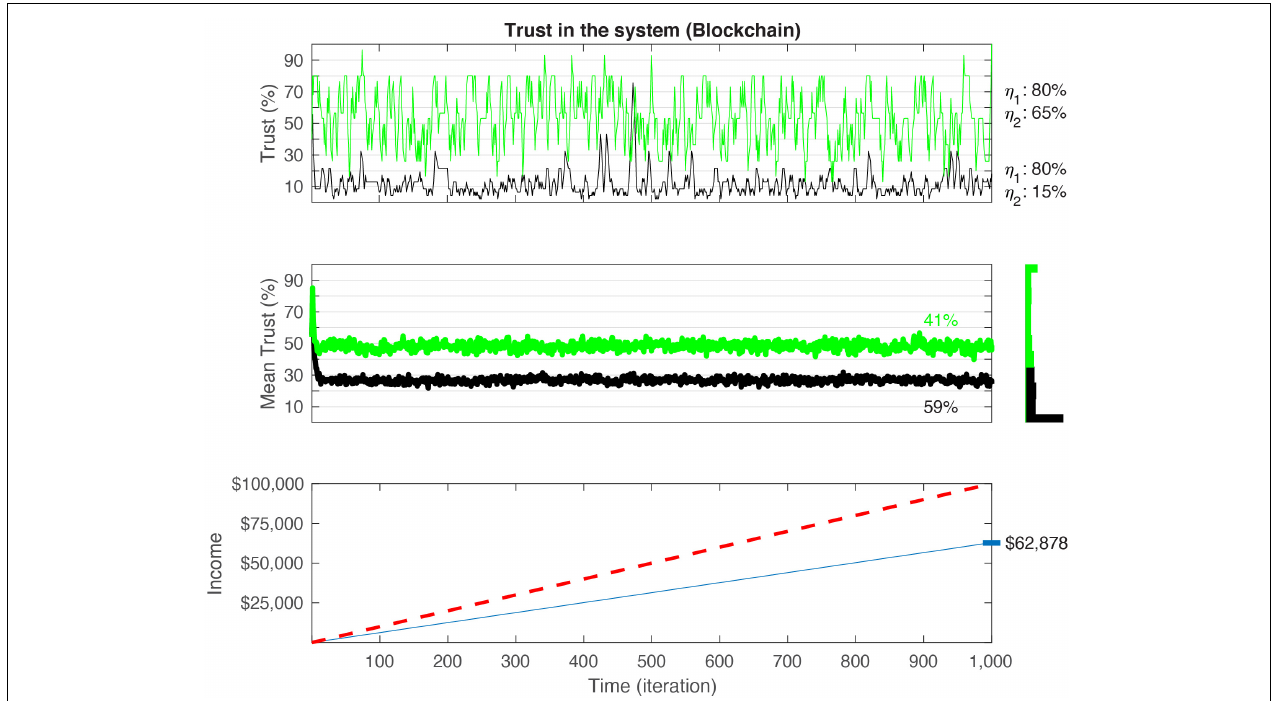
FIGURE 4 | Simulation of Blockchain games with varying values of η 1 and η 2 . (Top) Depiction of two examples of games with η 1 >> η 2 and η 1 ≈ η 2 ratios. (Middle) Trust (see equation 2) decays in 59% of games to a value lower than the mean (34%), irrespective of the initial trust and the ratio between η 1 and η 2 (black line in the Top, Middle ). Green line corresponds to the average of all trials that ended with trust values above the mean. A histogram of all final trust values is shown on the right. While high trust values have broader range, convergence to 0 trust is still dominant. This, however, has no effect on the individual/C-3PO income. (Bottom) Blue line corresponds to the average cumulative sum in the Blockchain games. The total cumulative sum generated by the C-3PO is $62,878. Red dashed line depicts the optimal (“Full trust”) revenue that the C-3PO could generate if all 1,000 trials were played with maximum payoff (1,000 × $100). Thin blue rectangle on the right axis corresponds to the upper/lower boundaries of income generated by the C-3PO, across all games. The values are stable and range between $61,000 and